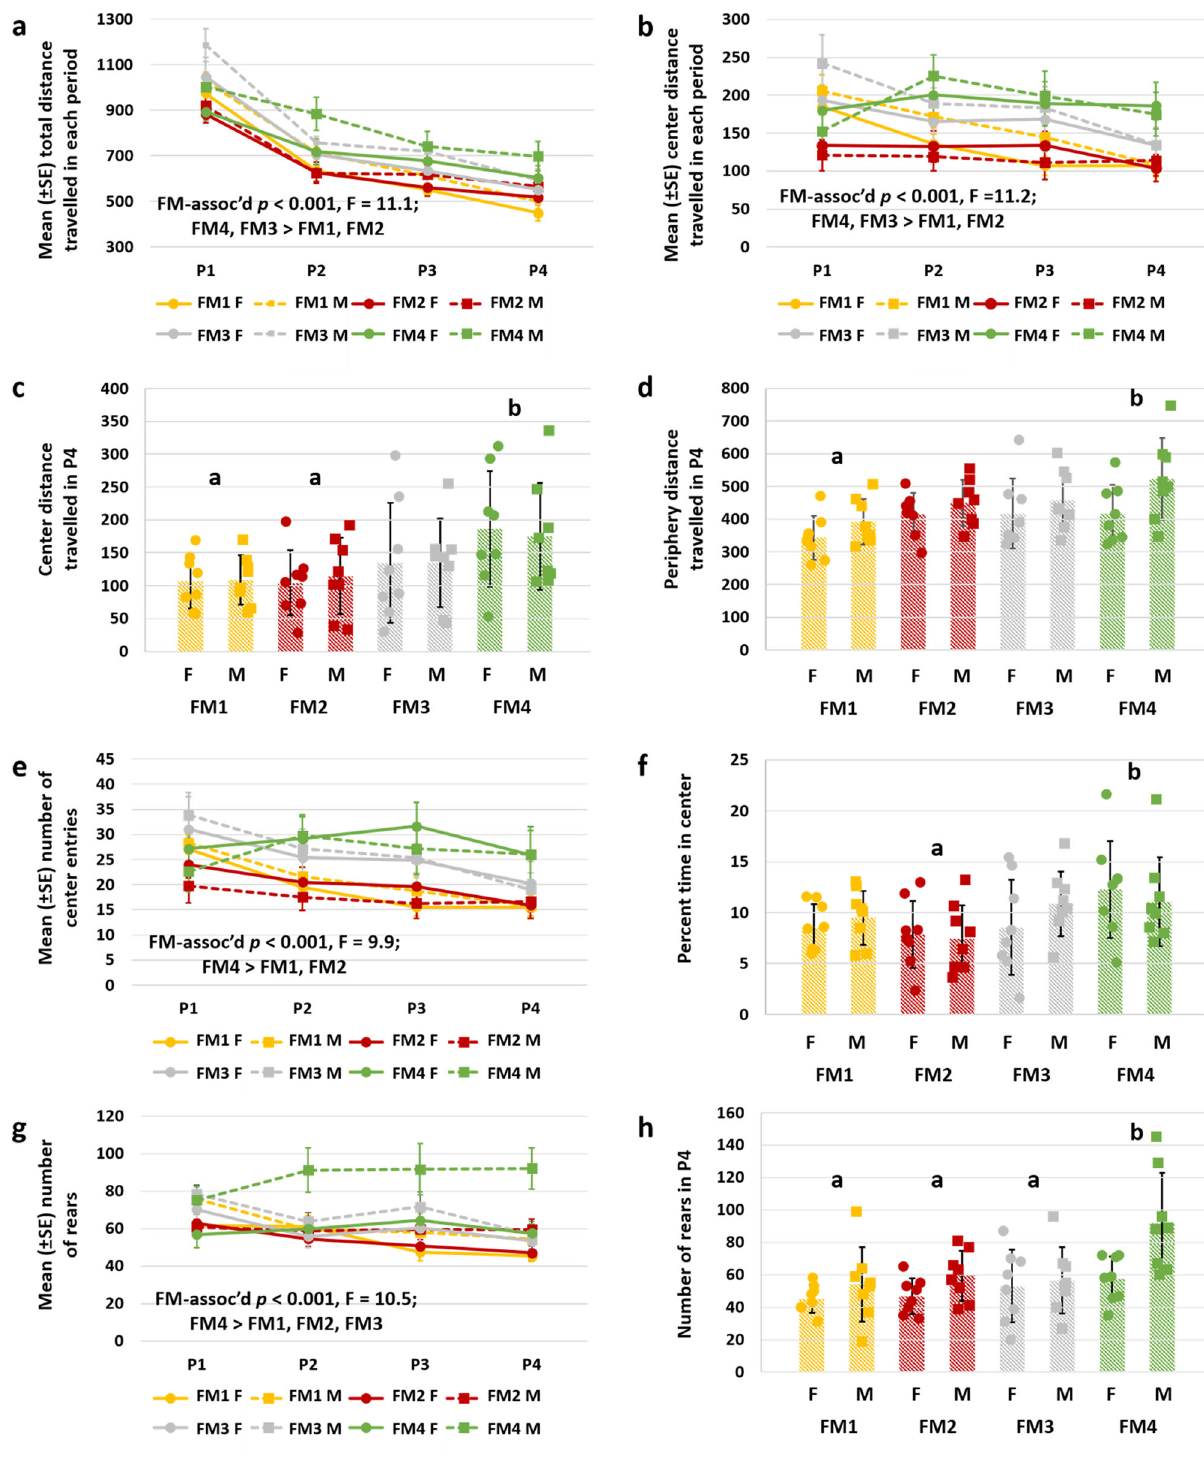
Fig. 2 Supplier-dependent FMs are associated with the different locomotor and exploratory activity. a Line chart showing mean (±SE) total distance traveled within each 5-min period (P1 – P4) in the open fi eld test. b Line chart showing mean (±SE) center distance traveled within each 5-min period (P1 – P4). c Dot plot showing center distance traveled during the fi nal 5-min period (P4), p = 0.011, F = 4.1. d Dot plot showing periphery distance traveled in P4 by the same mice. e Line chart showing the number of center entries during the entire time, p = 0.014, F = 3.8. f dot plot showing percent time in the center during the entire test period, p = 0.026, F = 3.3. g Line chart and h dot plot showing number of rears during the entire time and in P4 ( p = 0.003, F = 5.5), respectively. All data generated in female (F) and male (M) CD-1 mice harboring FM1, FM2, FM3, or FM4 ( n = 8/sex/FM). p and F values represent the main effects of FM in two-way ANOVA, and post hoc comparisons via Holm – Sidak method; signi fi cant pairwise FM-dependent differences are denoted by different letters, n = 8/sex/FM at all time-points, underlying bar charts represent mean ± SE.